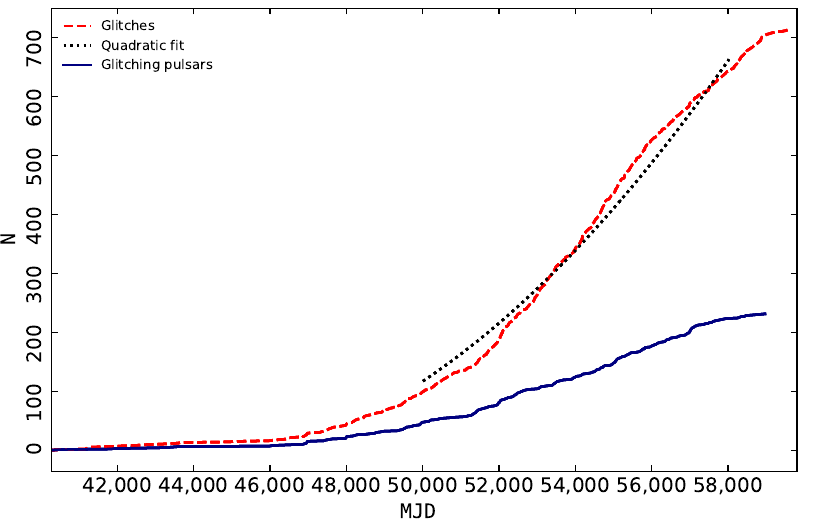
Figure 9. Cumulative number of the detected glitching pulsars (blue) and glitches (red) over time. A quadratic fit (black) to the glitch discovery N ∝ t 2 for 50,000 < MJD < 58,000 is carried out. The discovery epochs of glitching pulsars and glitches are collected from the combined glitch catalogues at ATNF and Jodrell Bank